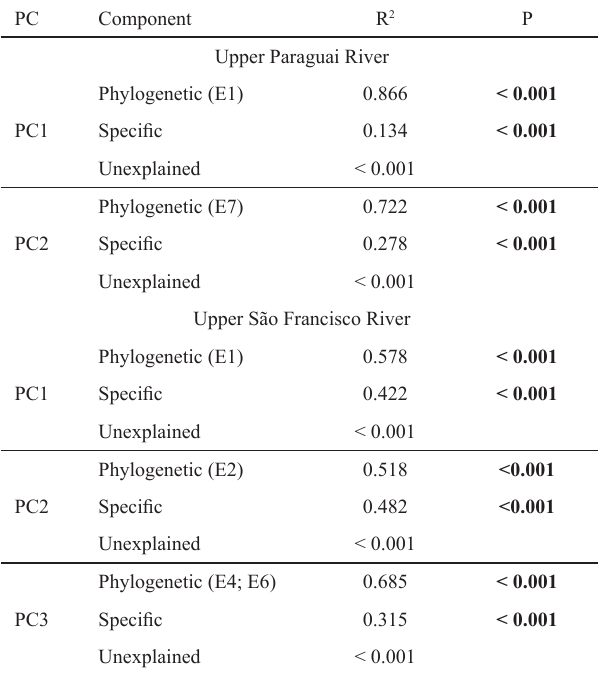
Table 2. Multiple regression of the significant principal components (PC) from the PCA based on 14 ecomorphological attributes of fishes from the upper Paraguai and upper São Francisco River basins, Brazil, against the phylogenetic (E = significant phylogenetic eigenvectors) and specific components of each PC, including the determination coefficient (R 2 ) and the P-value. The significant values ( P ≤ 0.05) are in bold.